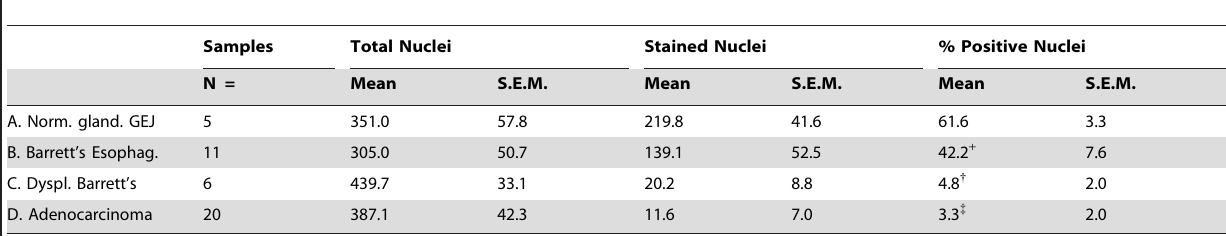
Table 1. Summary of Rfx1 immunohistochemistry